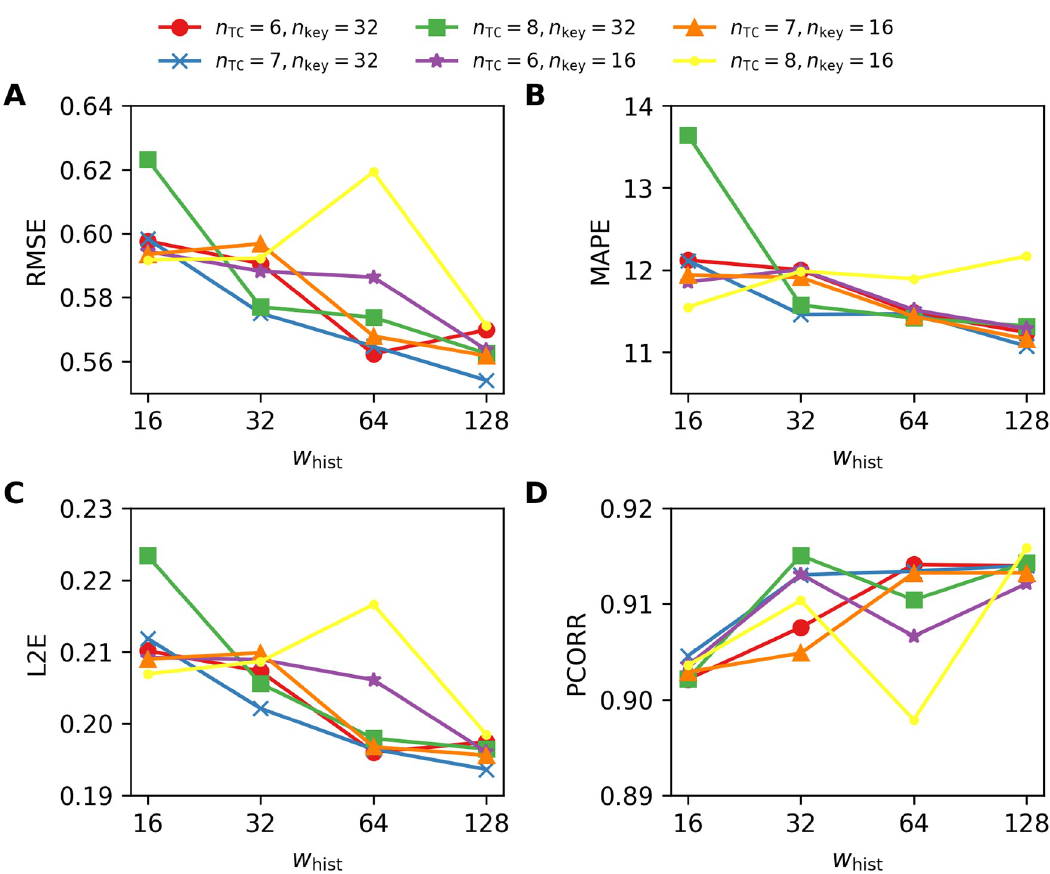
Fig 10. Four performance metrics for one-week-ahead predictions obtained by using the SNAILs for varying number of TC layers n TC = {6, 7, 8} with the kernel size n key = {16, 32}. A. RMSE, B. MAPE, C. L2E, and D. PCORR. Smaller values are preferable for RMSE, MAPE, L2E, and larger values are preferable for PCORR.